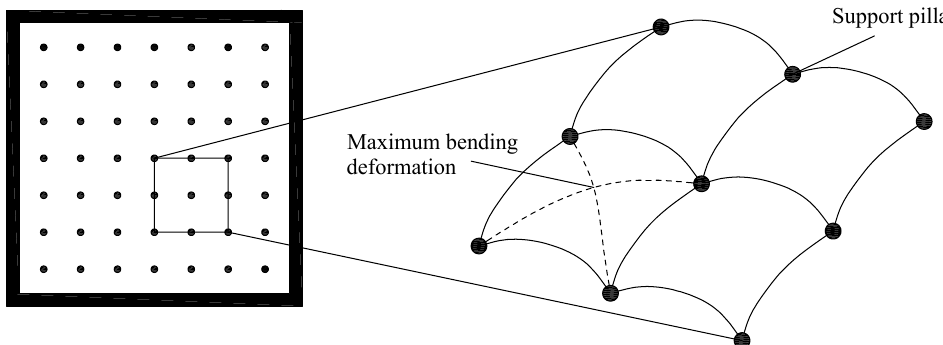
Figure 4. The maximum bending deformation of the glass substrate.